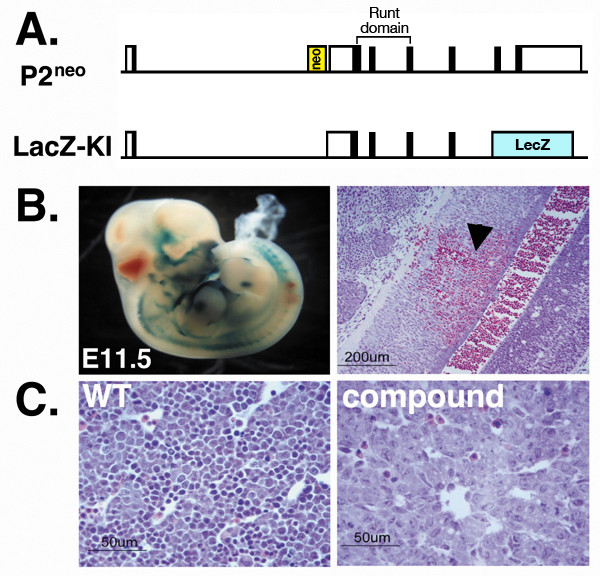
Runx1 P2neo allele failed to rescue the embryonal lethality phenotype of Runx1-/- mice. (A) Schematic representation of Runx1 locus in the two Runx1 mutant strains used to generate the compound mutant strain Runx1lz;Runx1P2neo. (B) Runx1lz;Runx1P2neo die at E11.5 to E12.5 due to hemorrhages in the CNS and/or lack of FL hematopoiesis. Left: Lateral view of a whole mount compound Runx1lz;Runx1P2neo E11.5 embryo stained for β-galactosidase activity. Hemorrhages are seen in the 4th ventricle, the ventral metencephalon and spinal cord. Right: Hematoxylin and eosin (H&E) staining of a section through the spinal cord exhibits focal hemorrhage (arrow head). (C) H&E staining of WT (left view) and Runx1lz;Runx1P2neo (right view) E12.5 fetal liver. Note the absence of definitive hematopoietic precursors (deep purple cells) in Runx1lz;Runx1P2neo FL as compared to WT. The data demonstrate that activity of a single Runx1 P1 was not sufficient to rescue the embryonal lethal phenotype of Runx1-/- mice.